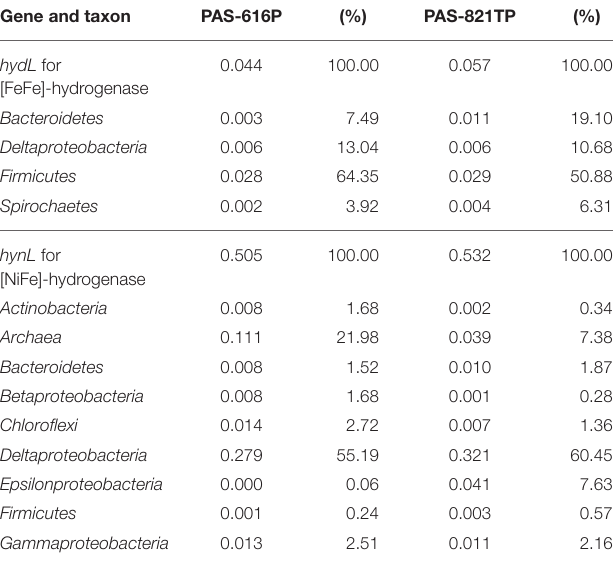
TABLE 3 | Taxonomic origin and abundance of hydL genes for [FeFe]-hydrogenase and of hynL genes for [NiFe]-hydrogenase in the PAS metagenomes.